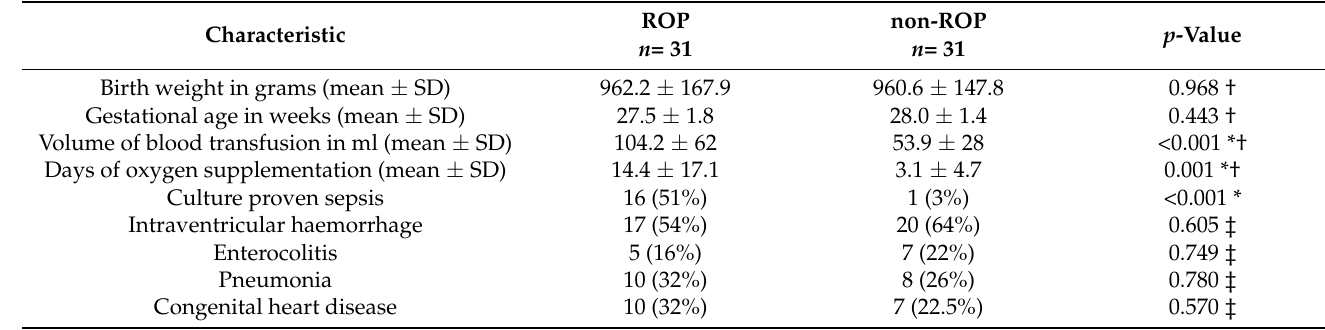
Table 1. Comparison of clinical characteristics between ROP and non-ROP group.